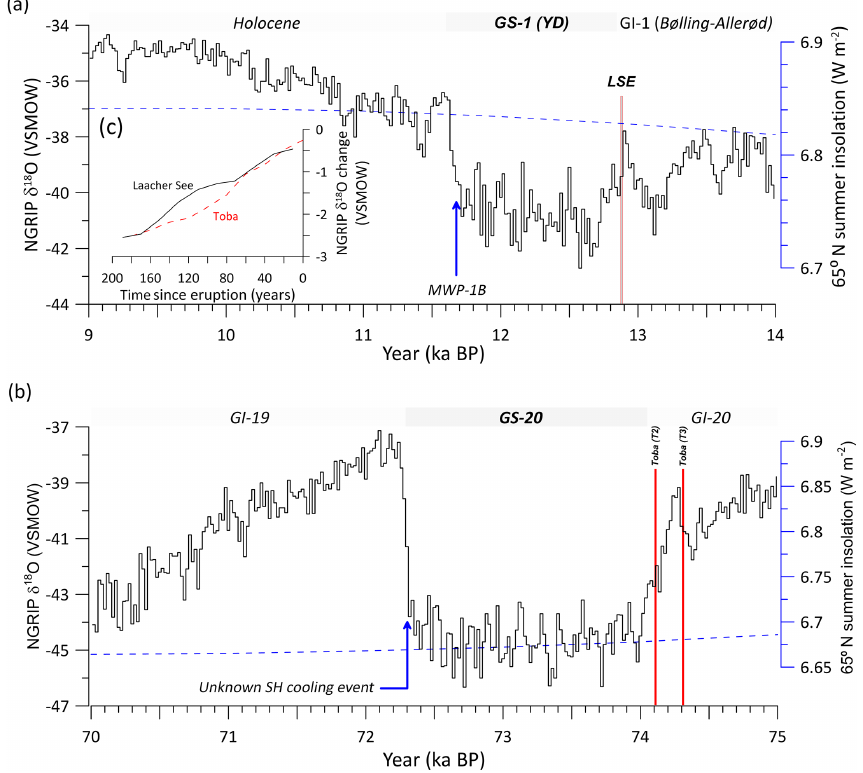
Figure 7. Two 5kyr intervals of the NGRIP δ 18 O record bracketing (a) the ∼ 12.9kaBP Laacher See eruption and (b) the ∼ 74kaBP Toba super-eruption (Rasmussen et al., 2006). The two eruptions are among the most well-dated eruptions of the Quaternary. The LST is not apparent in the NGRIP core (although we identify a candidate sulfate spike in the GISP2 record; see Fig. 5), and the timing of the LST relative to the NGRIP δ 18 O record is based on the difference in ages between the LST and the Vedde Ash found in European lake sediments (Lane et al., 2013a). The timing of the Toba eruption relative to NGRIP is based on the position of the most likely sulfate spike identified by Svensson et al. (2013). Blue arrows indicate the timing of possible SH cooling events. The timing of Meltwater Pulse-1B is based on Ridgwell et al. (2012), but the source, timing, and even occurrence of the meltwater pulse are still debated. The inset panel (c) shows NGRIP δ 18 O during the 200 years immediately following the two eruptions (the sulfate spike T2 is assumed to represent Toba, as suggested by Svensson et al.,